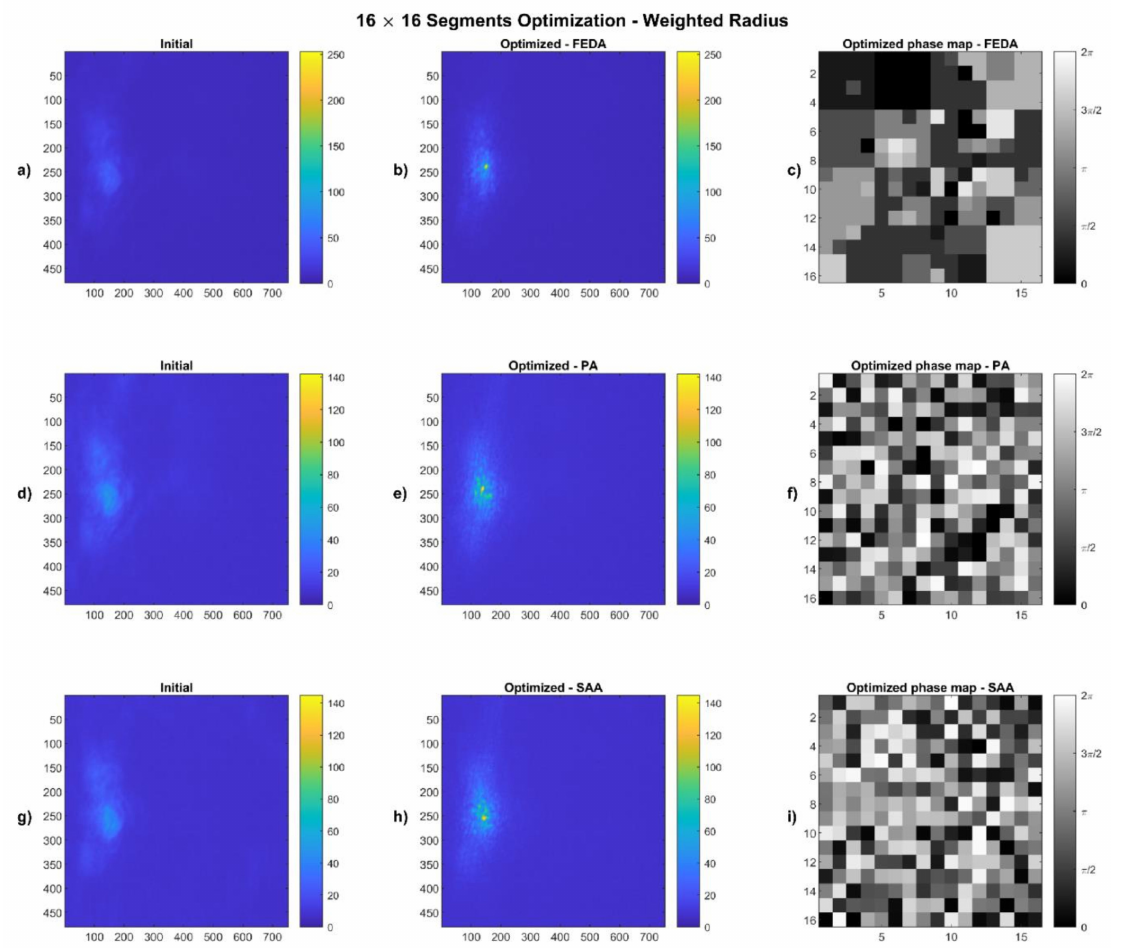
Figure 12. Results for the 16 × 16 segmentation of the phase map with the weighted radius being the cost function. ( a , b ), ( d , e ), ( g , h ) stand for the initial and optimized intensity distributions captured by the CMOS when running FEDA, PA, and SAA algorithms, respectively. All initial’s intensity distributions were captured before running each algorithm and after setting the phase of the incident beam to zero. For the intensity distributions, the grid values correspond to pixel units of the CMOS and the colorbar/intensity range can have values in between 0–255. ( c , f , i ) are the achieved optimal phase maps/matrices projected in the SLM after running FEDA, PA, and SAA, respectively. For the phase maps, its values range from 0 (black) to 2 π (white) with 10 values in between this